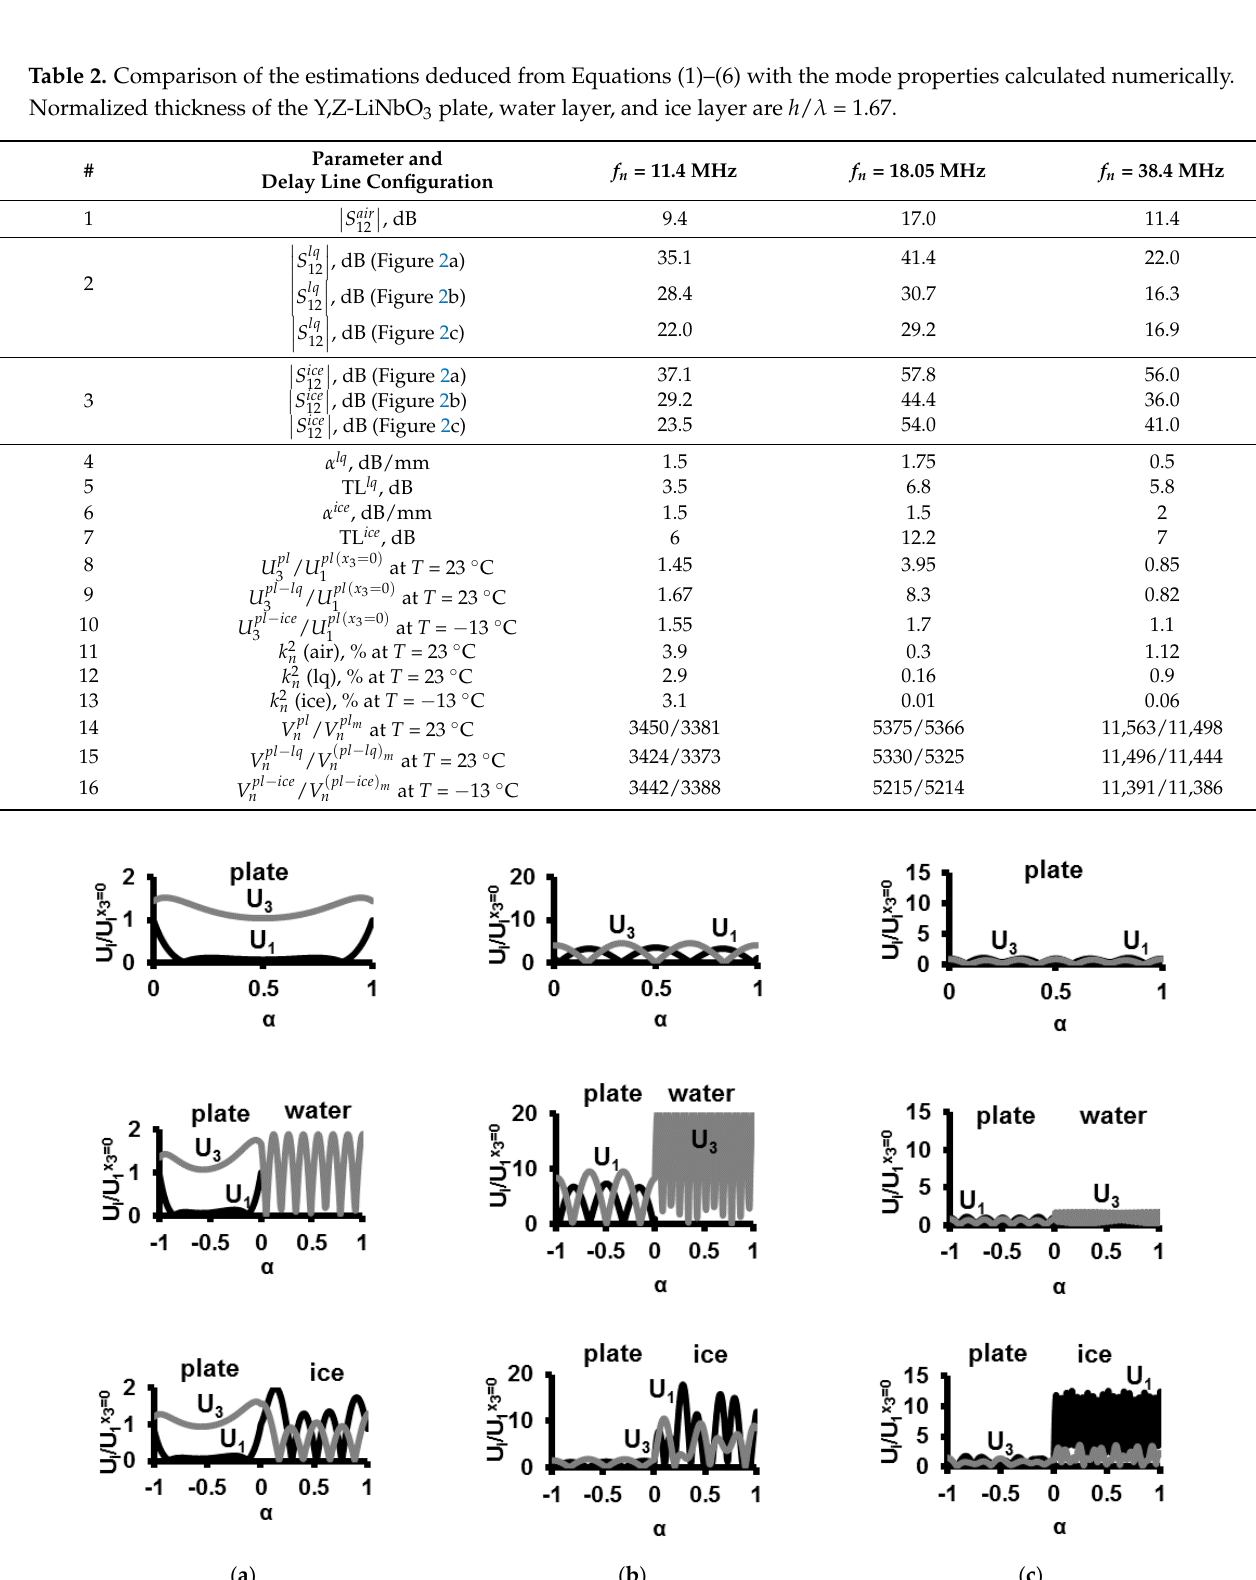
Figure 7. The profiles of the normalized mechanical displacements of the waves vs thickness x 3 = α × h/ λ of the structures calculated for uncoated Y,Z-LiNbO 3 plate (upper row), “Y,Z-LiNbO 3 plate—water layer” structure (middle row), and “Y,Z-LiNbO 3 plate—ice layer” (lower row) structure. The wave frequencies are 11.4 MHz ( a ), 18.05 MHz ( b ), and 38.4 MHz ( c ). The thickness of the plate and layers are h / λ = 1.67.